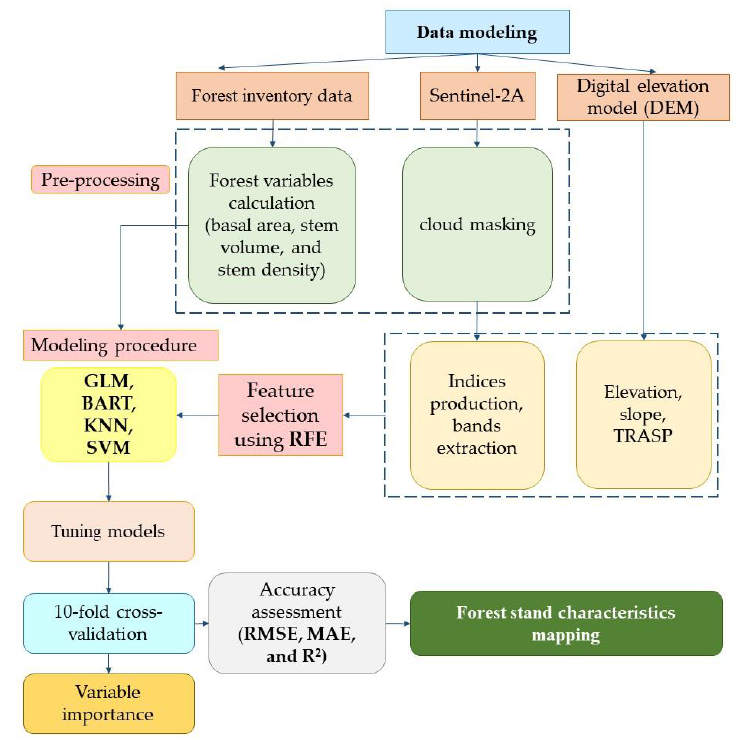
Figure 2. Framework of the proposed methodology.